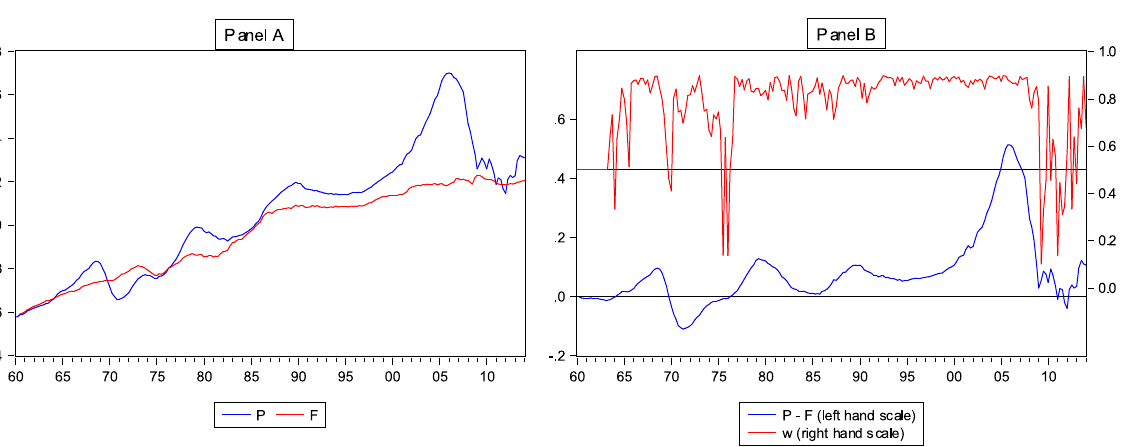
Fig 1. U.S. House Price Index and Fundamental Value Estimate. Panel A of Fig 1 displays the log-real U.S. house price index P t and the log-real fundamental value estimate F t . The upper part of Panel B displays the weight W t , the fraction of investors using the fundamentalist forecasting rule (right axis). The lower part of Panel B (left axis), displays P t- F t , the difference between the house price and its fundamental